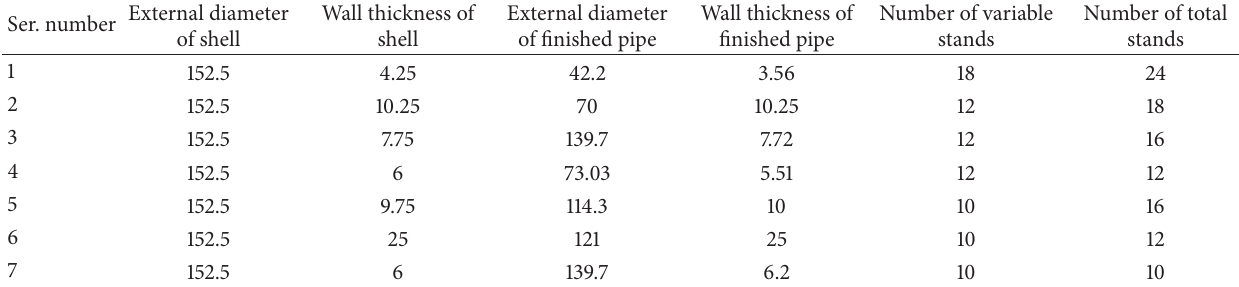
Table 1: Size table of reducing tube.